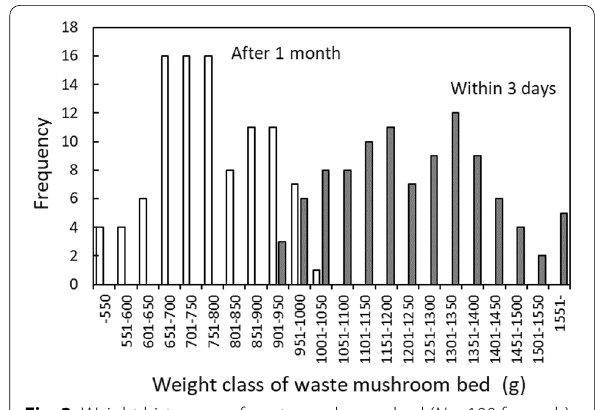
Fig. 3 Weight histogram of waste mushroom bed ( N